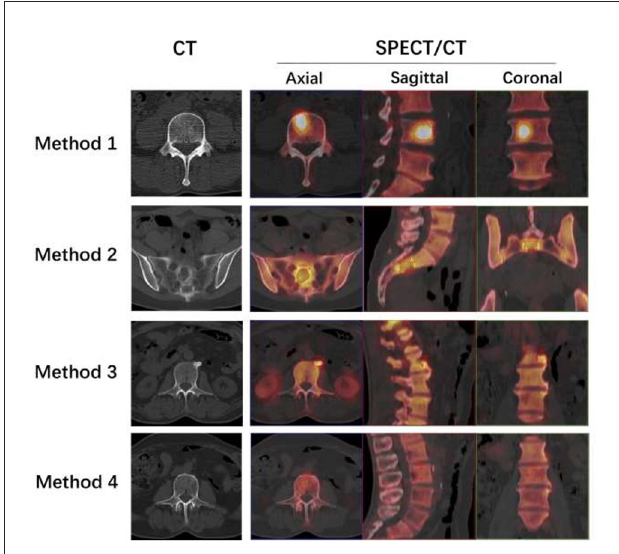
FIGURE1 Four methods to delineate different VOIs. Method 1 : The L4 bone metastatic lesion was delineated by putting the tumor VOI at 40% of the SUVmax on the SPECT/CT fusion images of axial, sagittal, and coronal sections. The axial section of CT showed no abnormal density changes. Method 2 : The Siemens “Multi-frame Polygon” tool was used to manually draw an osteolytic bone metastatic lesion of the sacrum on axial SPECT/CT fusion sections from the top to the bottom of the lesion. Then, the sagittal and coronal images were automatically delineated. The axial section of CT showed osteolytic bone destruction of sacrum. Method 3 : On axial, sagittal, and coronal SPECT/CT fusion sections, the hyperosteogeny lesion of L2 was delineated using the “Ellipsoid” tool. The axial section of CT showed osteophytes of L2. Method 4 : The visually normal L3 vertebral body was delineated on axial, sagittal, and coronal SPECT/CT fusion sections with volumes not more than 5 cm 3 using the “Ellipsoid” tool, excluding the bone cortex. The axial section of CT showed normal vertebrae of